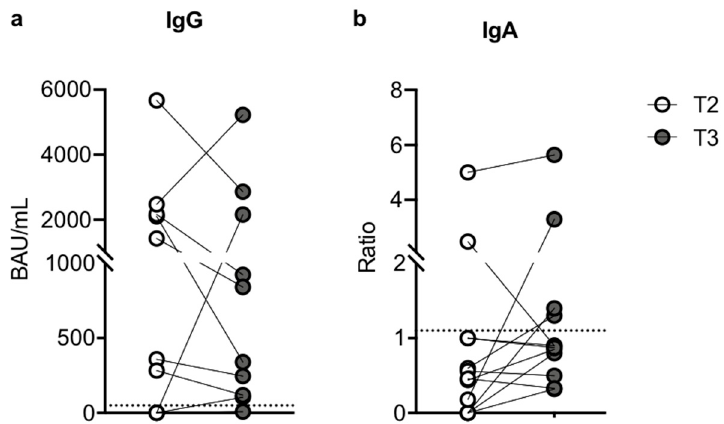
Figure 4. Comparison of humoral responses in infected–vaccinated SOTRs at T2 and after SARS-CoV-2 infection (T3) (n = 12). ( a ) Comparison of anti-SARS-CoV-2 S1/S2 IgG concentration between T2 (white dots) and T3 (grey dots). Samples with anti-SARS-CoV-2 S1/S2 IgG concentration > 33.8 BAU/mL were considered positive. ( b ) Comparison of anti-SARS-CoV-2 S1 IgA Ratio between T2 (white dots) and T3 (grey dots). Ratios ≥ 1.1 were considered positive. The connection lines represent the antibody value of each subject at T1 and T2, while the dotted line corresponds to the threshold. The significance was determined using the Mann–Whitney U test.